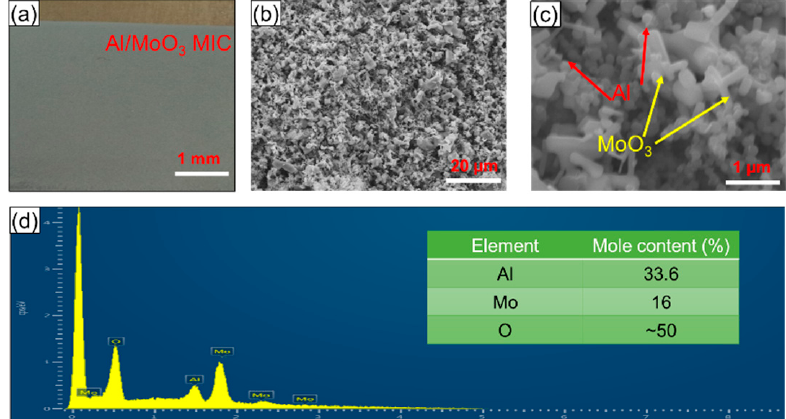
Figure 4. ( a ) Optical and ( b , c ) typical field emission scanning electron microscope (FESEM) images of the nano-Al / MoO 3 MIC films prepared using electrophoretic deposition (EPD); ( d ) energy dispersive X-ray spectroscopy (EDX) spectrum of the product with an inserted table showing the mole content (%) of all